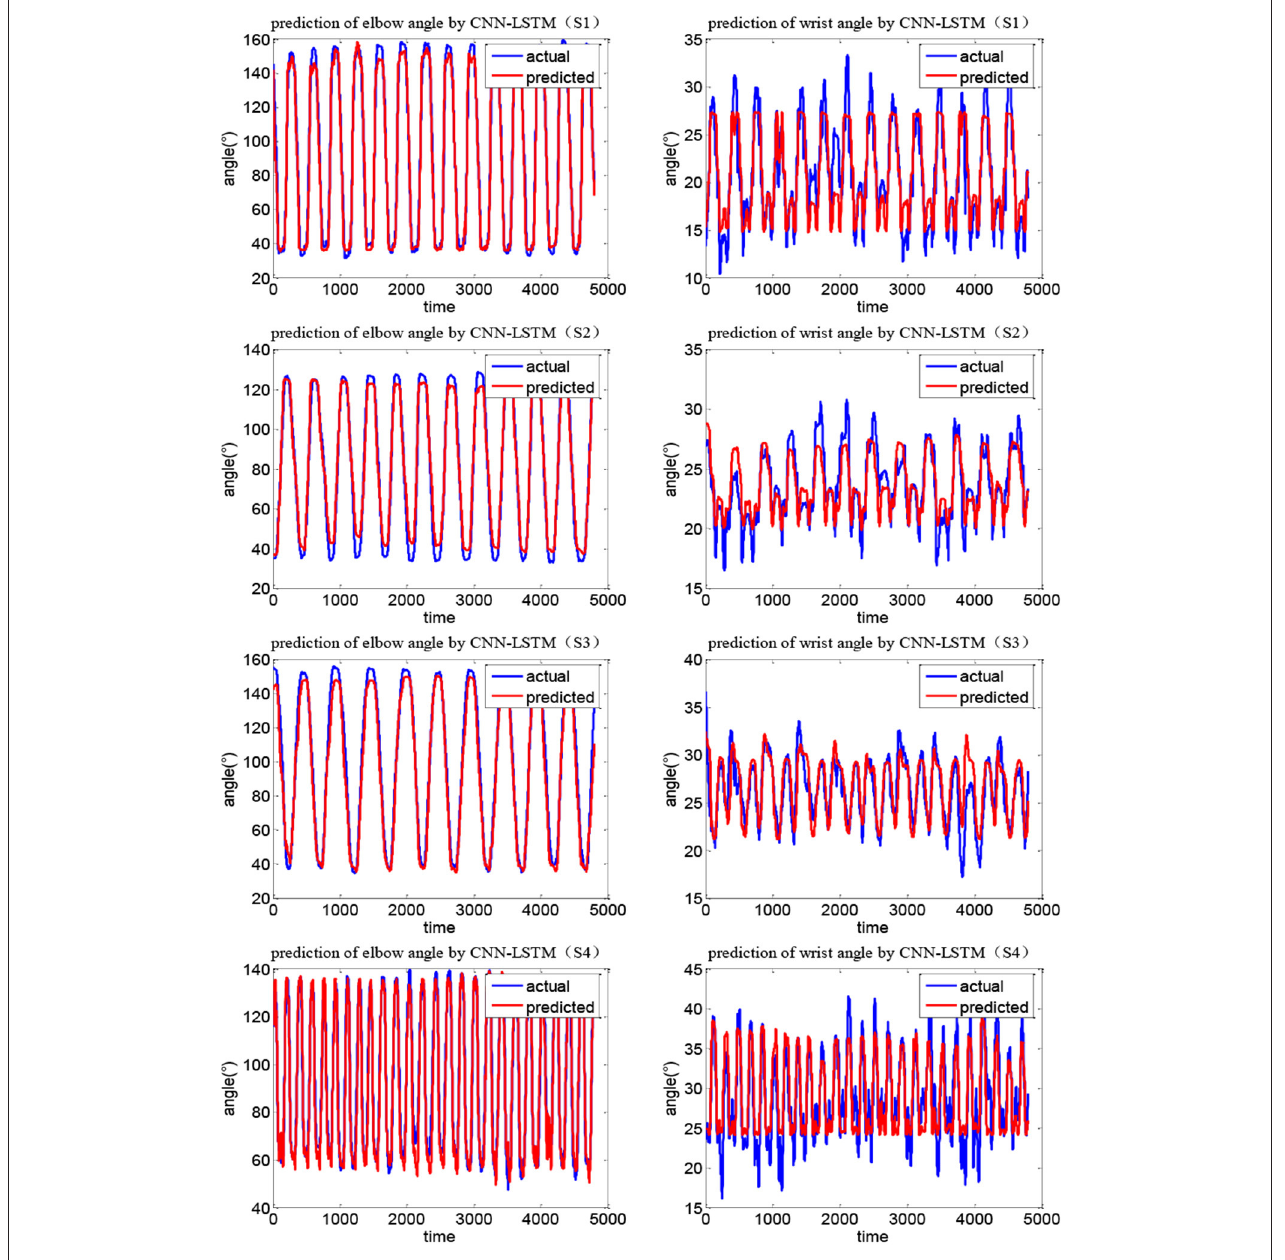
FIGURE 13 | Joint angle prediction results of four subjects (Task